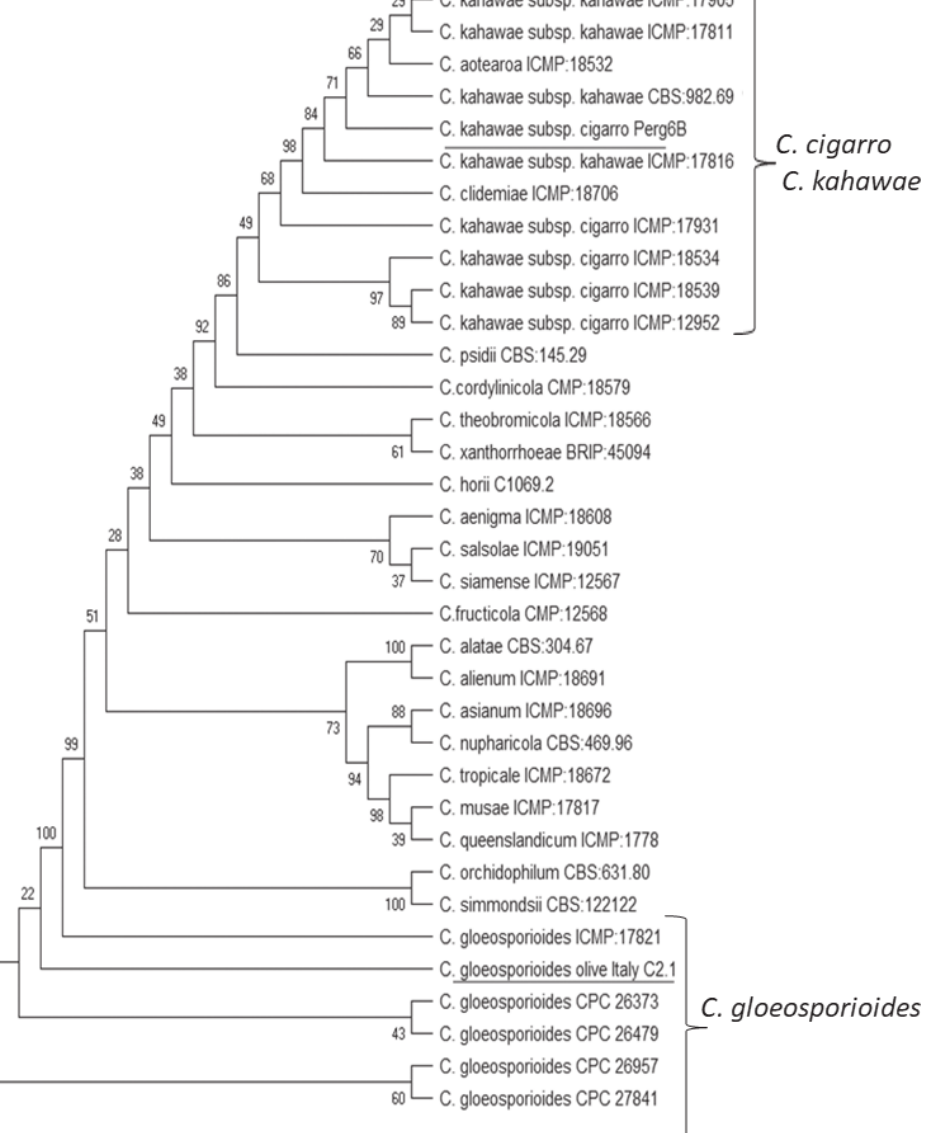
Figure 2. Phylogenetic analysis of the 35 Colletotrichum gloeosporioides species complex strains listed in Supplementary Table S1, based on a multilocus concatenated alignment of the ITS , GAPDH, ACT , and TUB2 genes. The evolutionary history was inferred using the Maximum Parsimony method. Colletotrichum orchidophilum CBS 632.80 was used as an outgroup. The percentages of replicate trees in which the asso- ciated taxa clustered together in the bootstrap test (1000 replicates) are shown next to the branches. Strains described for the first time are